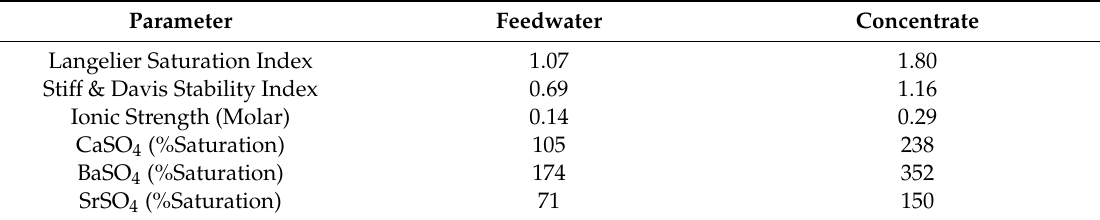
Table 2. RO system scaling simulated by ROSA modeling for desalination of Well 2 groundwater.